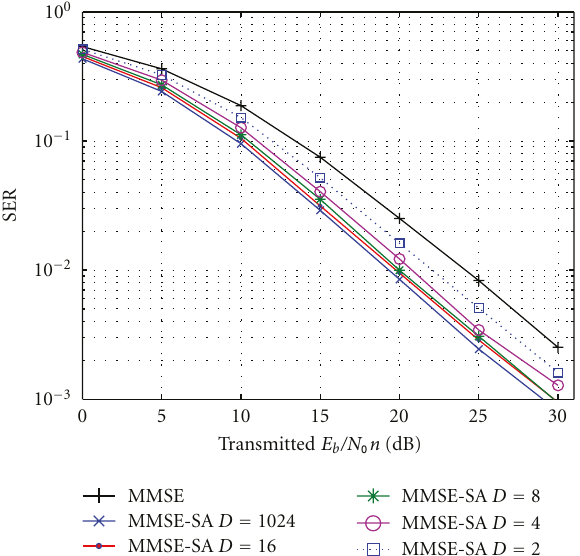
Figure 6: SER versus D for MMSE (SNR = 20dB, 25dB) and V- BLAST (SNR per rx antenna = 20dB) using SA, N = M = 5, N t = 7,